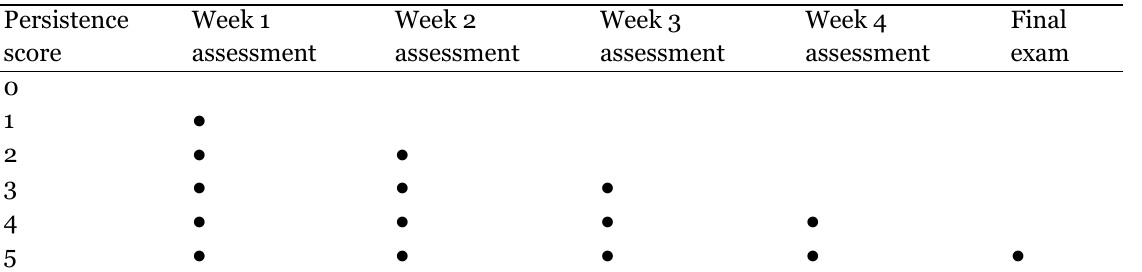
Assessment Persistence Scoring